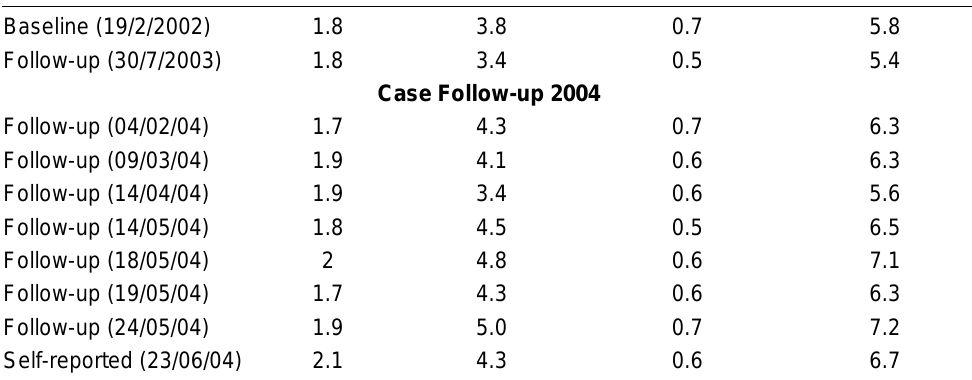
Details of Blood Cholesterol Tests Over Several Time